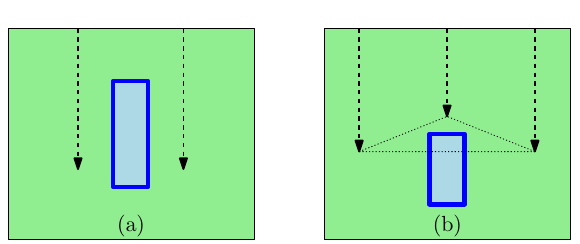
Figure 4: Trajectories (in dashed, black) over a geographic context modeled as polygonal subdivision (in bold,